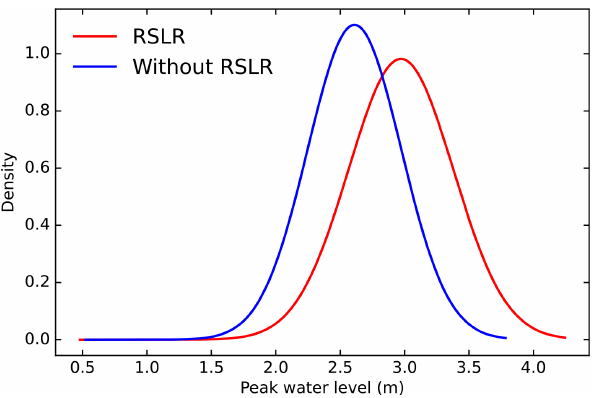
Figure 4. The shift of the probabilistic distribution of the peak water level in Shanghai during 1961–2018 with the RSLR and without the